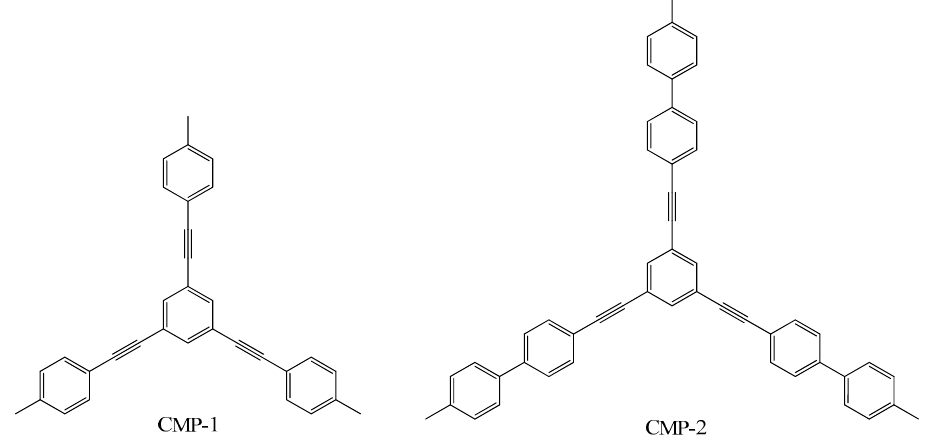
Figure 5. Chemical structure of 1,3,5-tris(p-tolylethynyl)benzene (CMP-1) and 1,3,5-tris((4’-methyl- [1,1’-biphenyl]-4-yl)ethynyl)benzene (CMP-2).